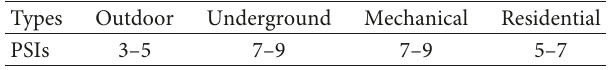
Table 2: PSIs of different types of parking